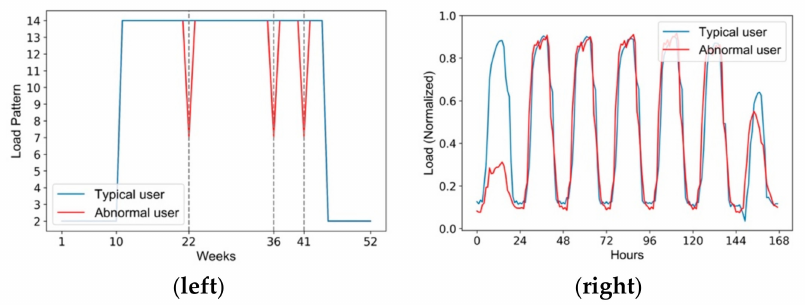
Figure 15. The impact of holidays on Strip Mall users with user behavior ( left ) and load patterns ( right ).